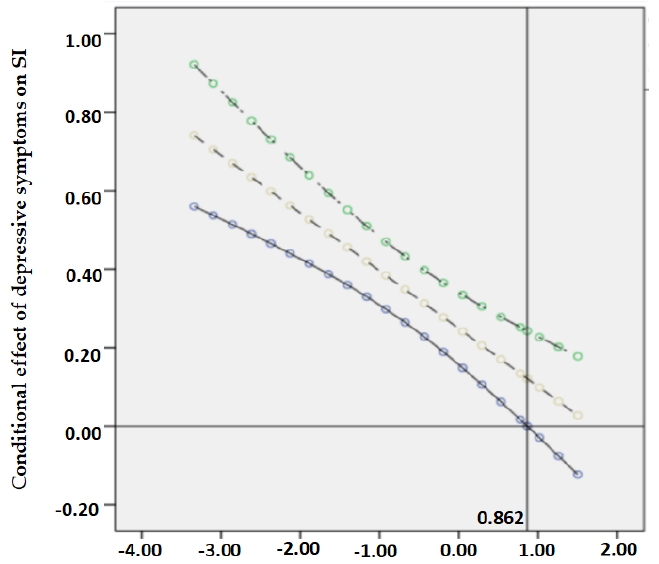
Figure 4. A plot of the effect of depressive symptoms on SI at values of resilience.